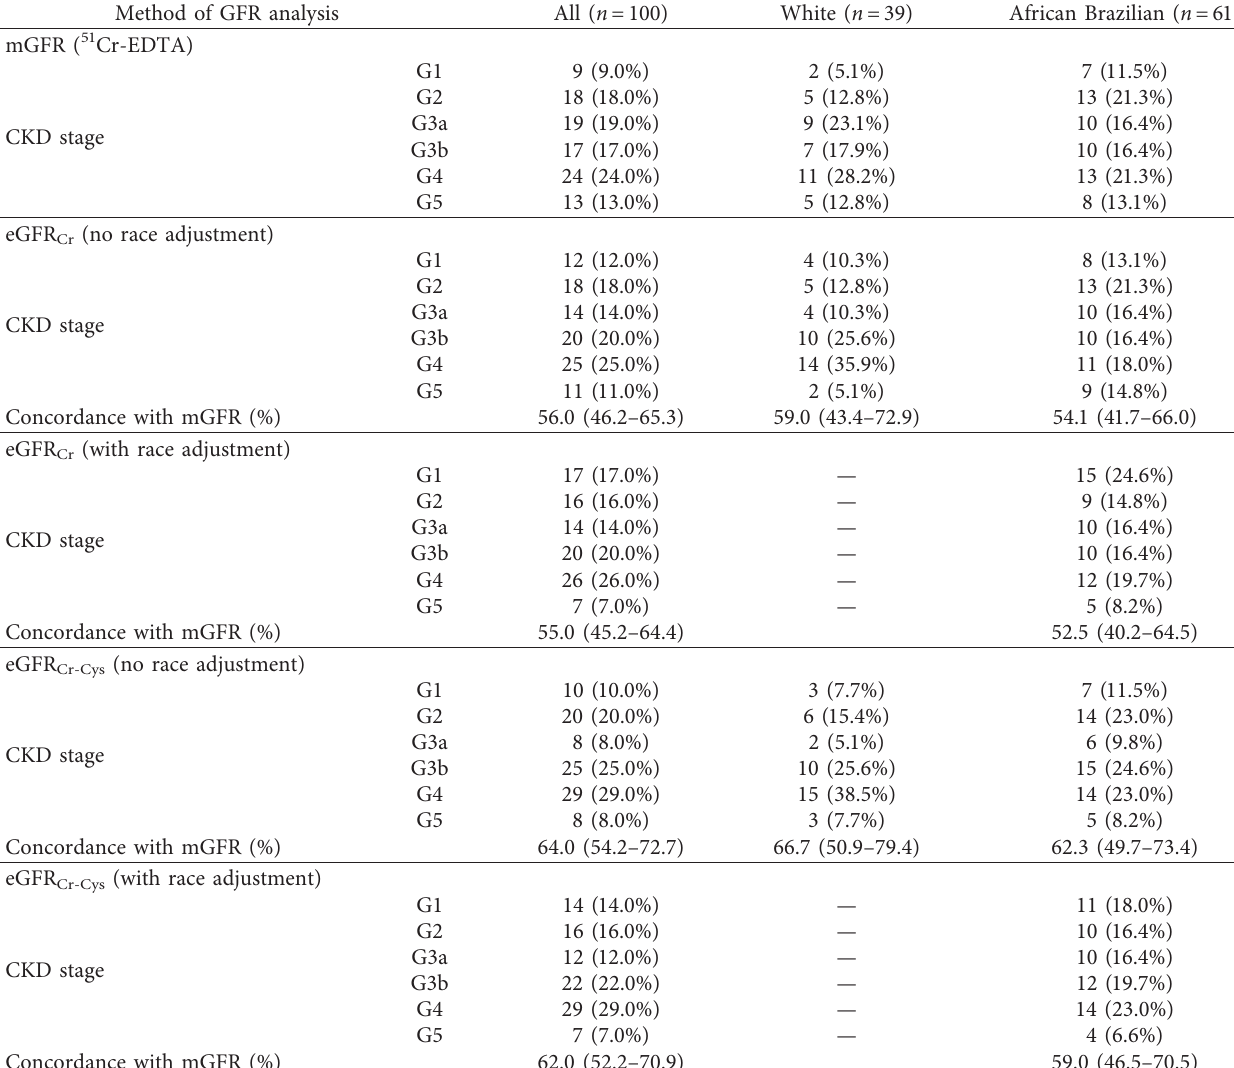
Table 4: Distribution of patients according to KDIGO classification of CKD staging, based on mGFR and eGFR, and the concordance rate of CKD staging between eGFR and